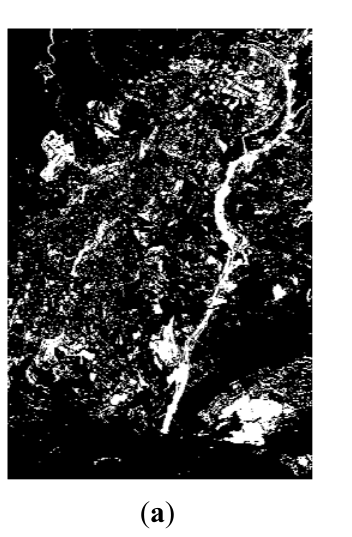
Figure 6. Level 1 thresholded indices: best results ( a ) CVA–Li method (binary image); ( b ) NDVI–Otsu method (binary